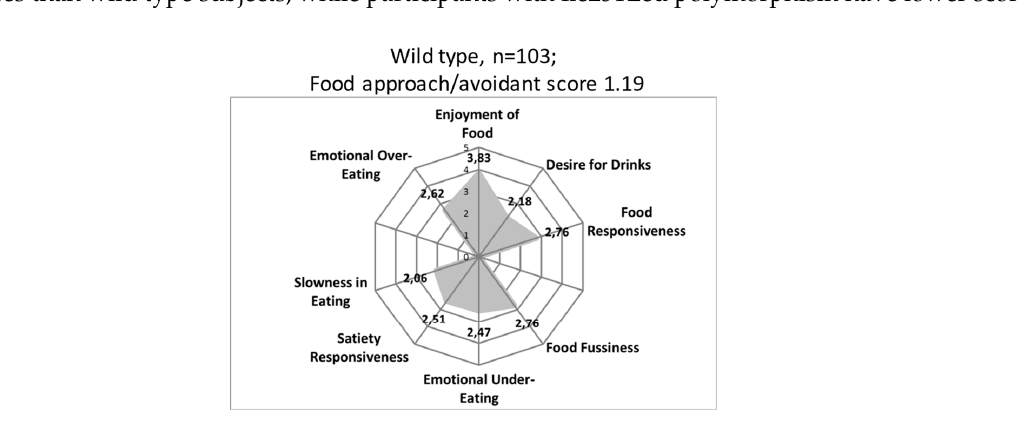
Figure 1. Childhood Eating Behavior Score (CEBQ) in Spanish children with abdominal obesity. The Food approach/avoidant score refers to the quotient between the sums of scores of the “food approach” subscales divided by the sum of the scores of the “food avoidant” subscales. Subjects with mutations in MC4R (Thr124Met, Thr150Ileu) and LCN2 (Thr124Met) genes were evaluated. 3.4. Change in BMI-SDS and Mutations in MC4R and LCN2 After 8-Week and 1-Year of Follow up Carriers of mutations that lead to a reduced function in MC4R and LCN2 genes showed a disparity of responses to the lifestyle intervention (Table 3). Changes in BMI-SDS of the five subject carriers of the Ile251Leu polymorphism are quite variable with two of them not showing any improvement at 1 year. Moreover, no significant differences in BMI-SDS changes were found after eight weeks or one-year of follow up in mutated carriers vs. non carriers subjects in analysis conducted in matched age and sex subjects with and without a functional mutation in MC4R (Supplementary Table S3).